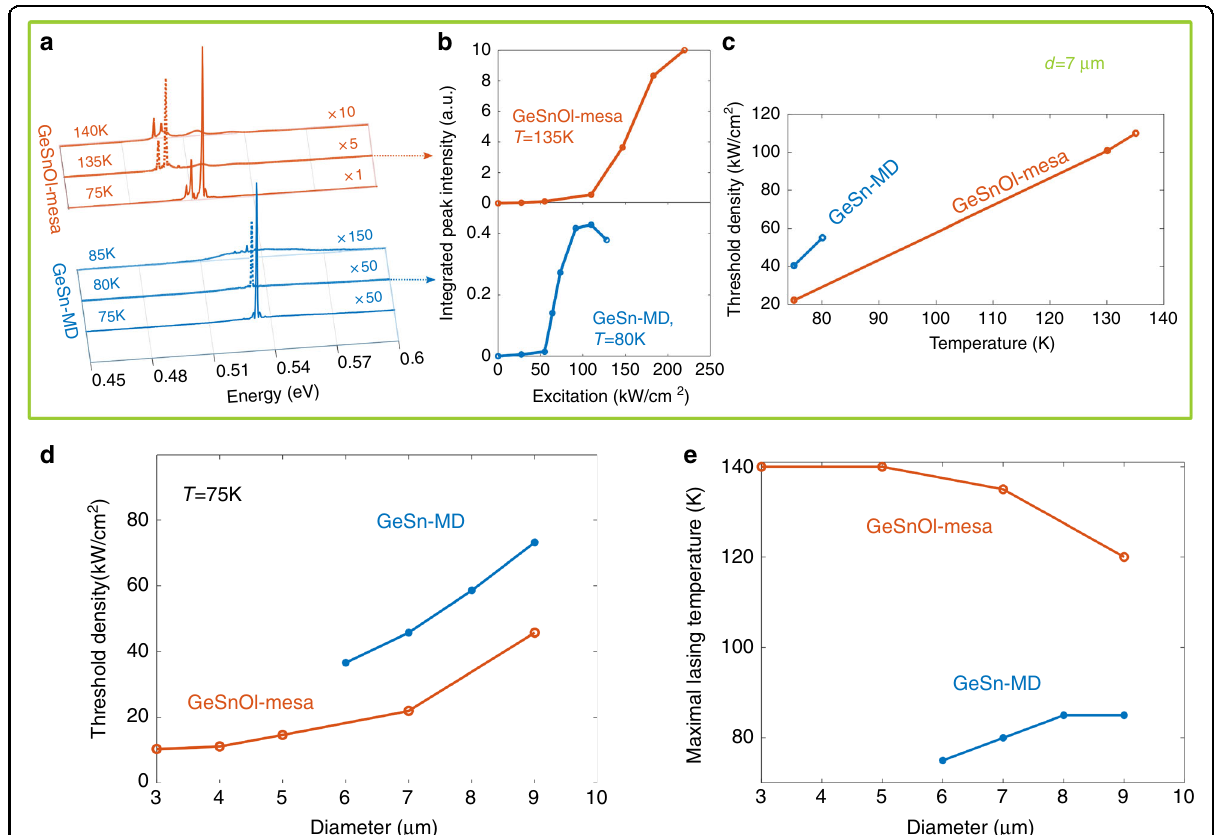
Fig. 4 Improved lasing performances with GeSnOI. a Pulsed PL spectra of 7 µm diameter GeSn microdisks and GeSnOI mesas with 360-nm-thick GeSn above the threshold at 75 K (solid curves), at maximum lasing temperatures (dotted curves) and at temperatures 5 K higher (dashed curves). The laser intensities in GeSn MDs and GeSnOI mesas are the highest for 91.5 and 183 kW/cm 2 excitation power densities, respectively. b L – L curves for GeSn MDs and GeSnOI mesas at their maximum lasing temperature, 80 and 135 K, respectively. c Temperature dependence of threshold densities for 7 µm diameter GeSn MDs and GeSnOI mesas. d Power density thresholds at 75 K for different diameter GeSn-MD and GeSnOI mesa lasers. e Highest lasing temperatures for different diameter GeSn MDs and GeSnOI